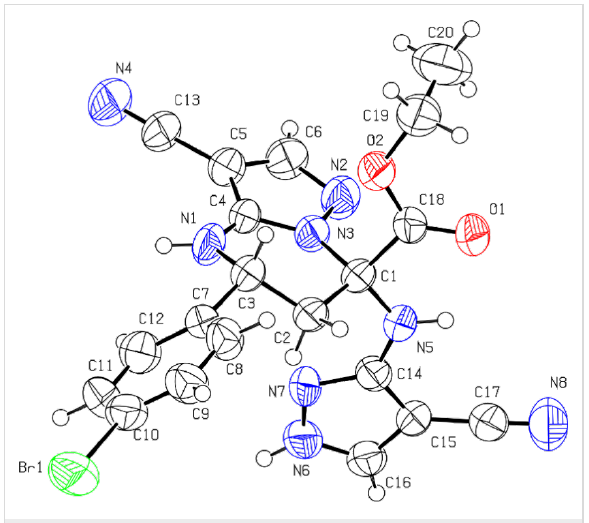
Figure 2: Molecular structure of ethyl 5-(4-bromophenyl)-3-cyano-7- ((4-cyano-1 H -pyrazol-5-yl)amino)-4,5,6,7-tetrahydropyrazolo[1,5-